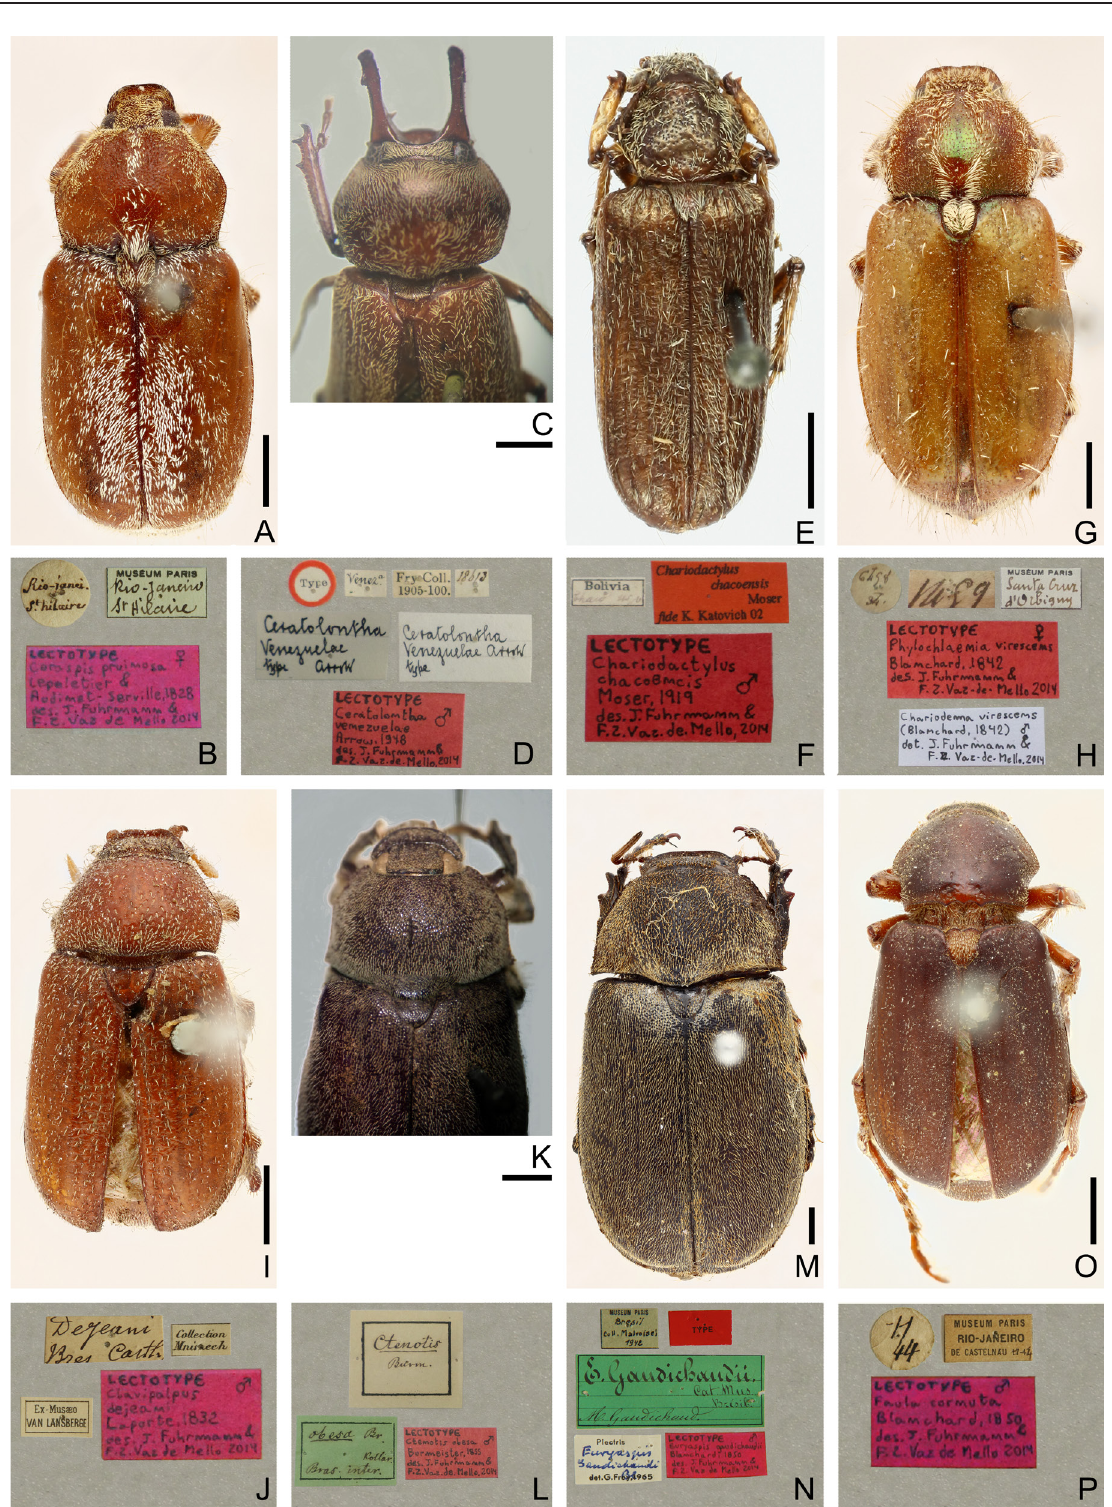
Fig 18. Lectotypes (dorsal, labels). A–B . Ceraspis pruinosa LePeletier de Saint-Fargeau &